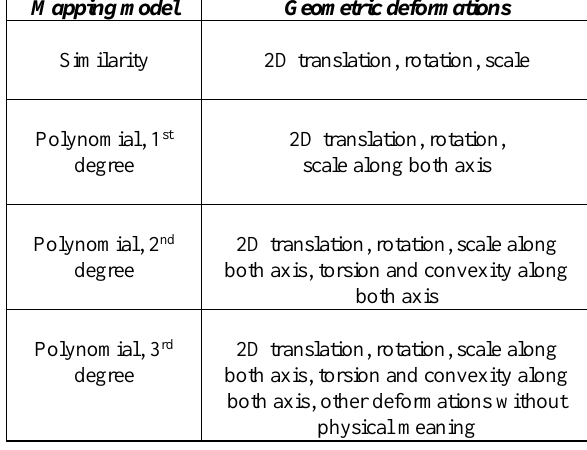
Table 1. Deformations modelled by different mapping functions.